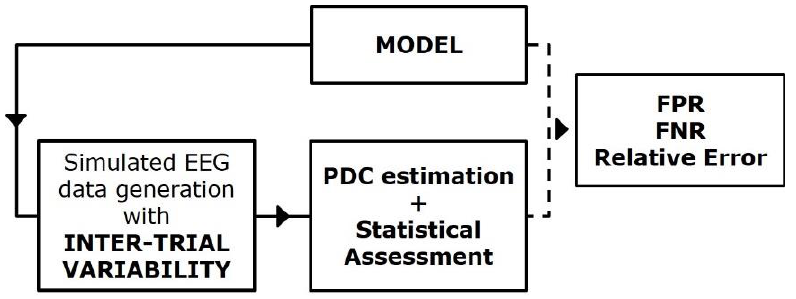
Figure 4. Simulation study for the PDC robustness assessment. Block diagram describing the simulation framework built for quantifying the effect of the inter-trial variability on connectivity estimates ’ performances.